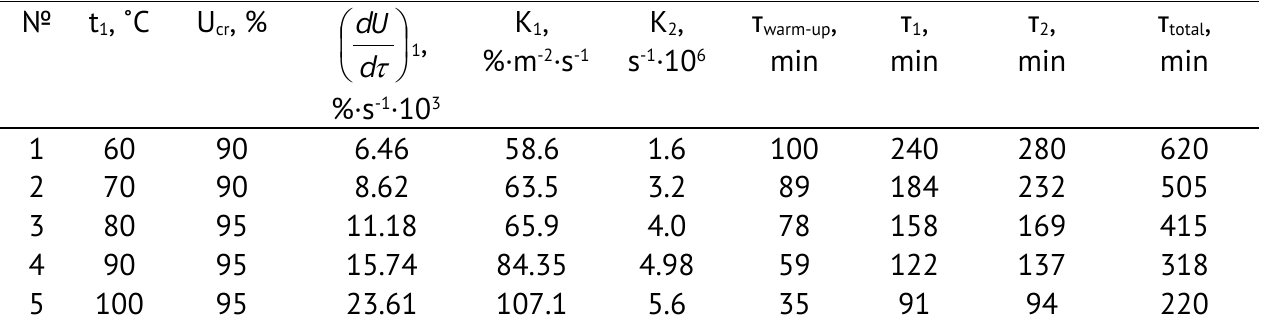
Experimental data on the drying kinetics of apricot stones by the convective method